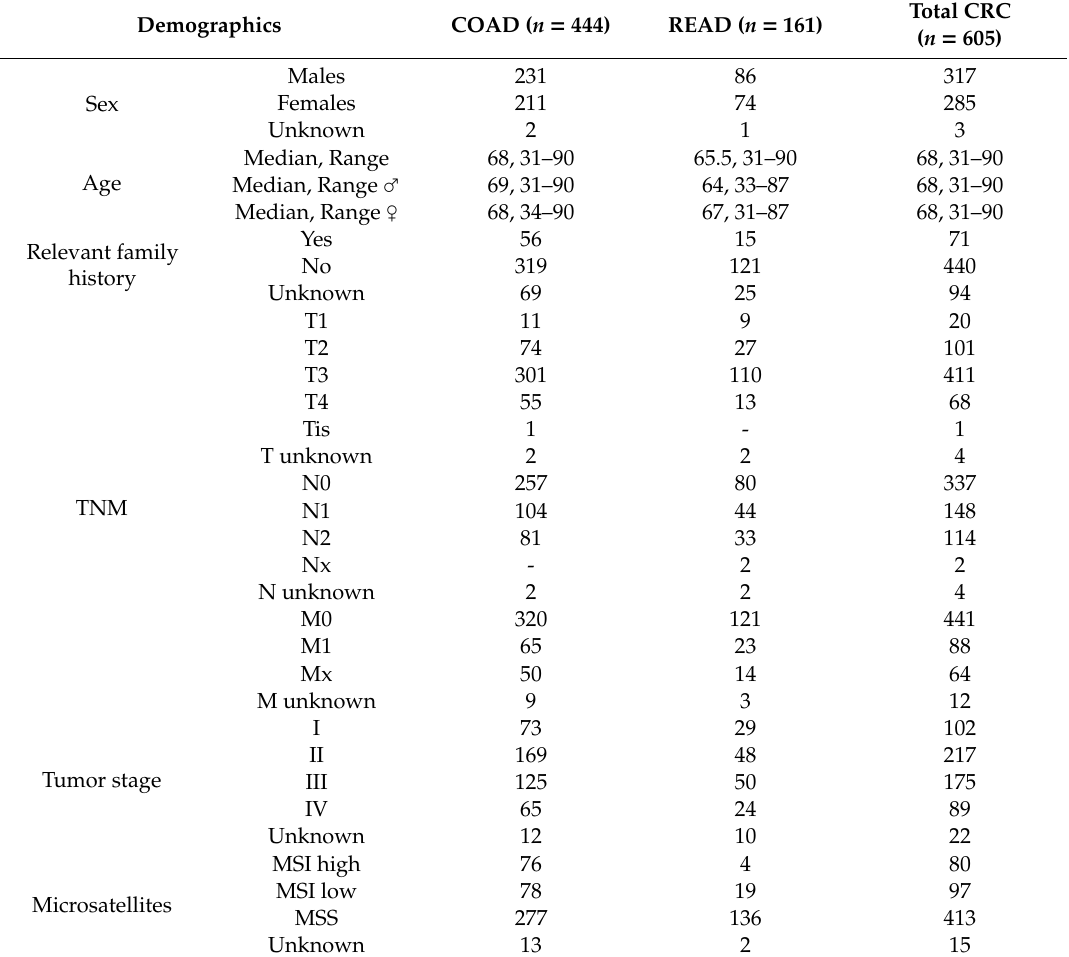
Table 1. Clinical data for the The Cancer Genome Atlas (TCGA) dataset, representing 444 cases of colon adenocarcinoma (COAD) and 161 cases of rectum adenocarcinoma